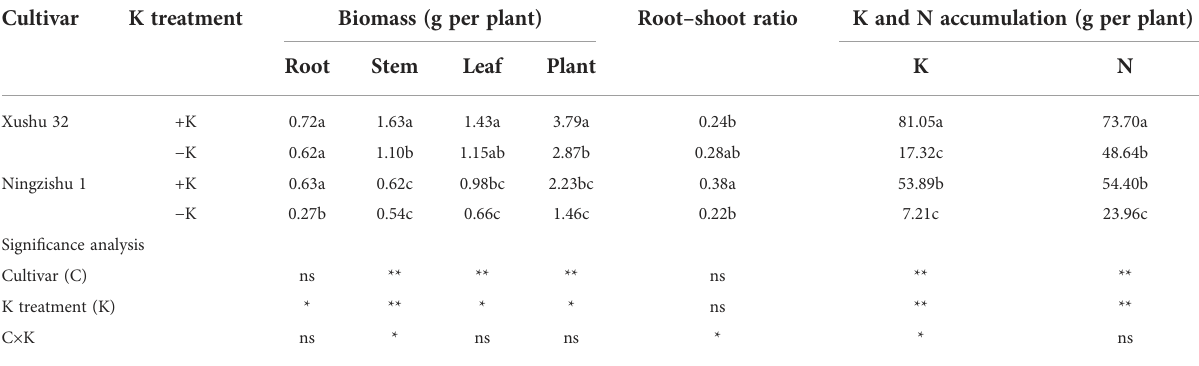
TABLE 1 Growth parameters, K accumulation, and N accumulation of sweet potato seedlings as affected by the different K treatments.